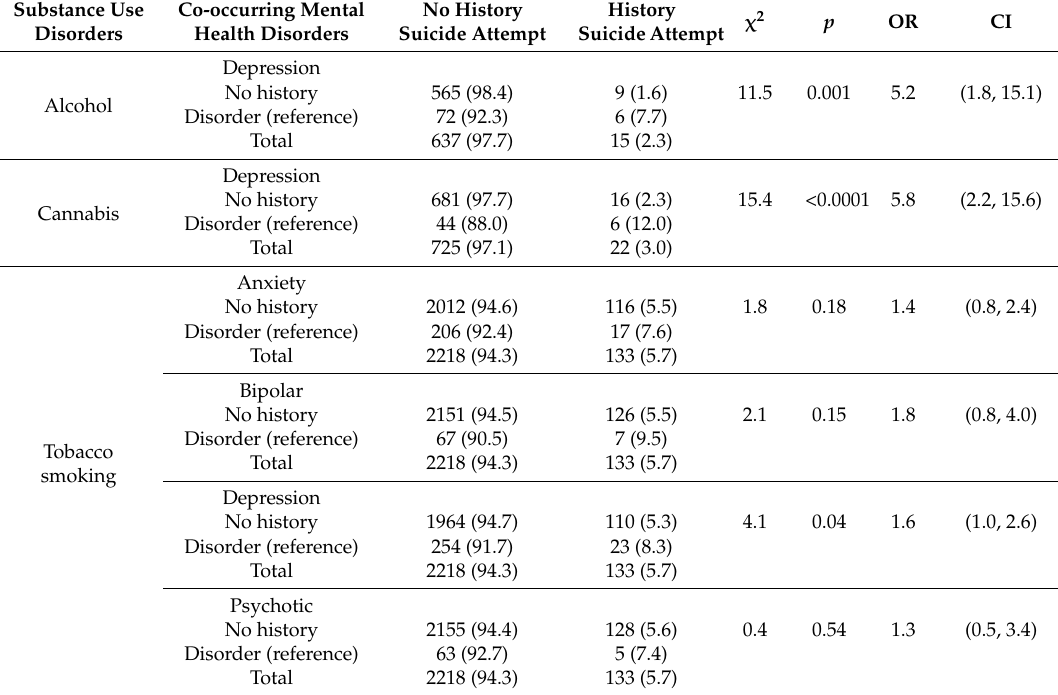
Table 8. Odds of suicide attempt for co-occurrence of substance use and mental health